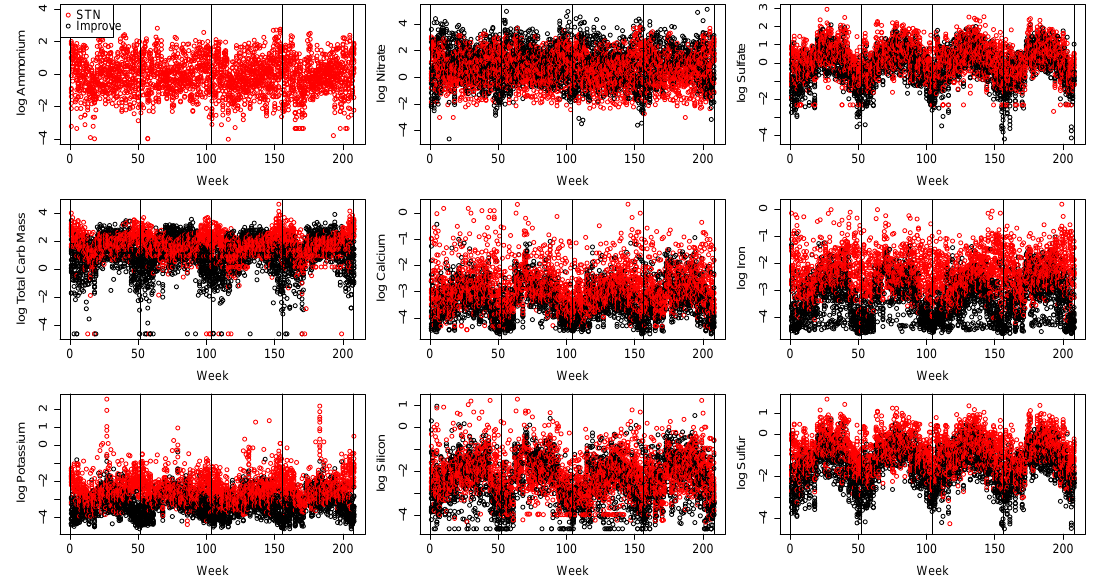
Figure 1. STN and IMPROVE stations speciated components for the years 2003–2006 weekly averages for each site where the vertical lines separate each year. Ammonium is only collected at STN